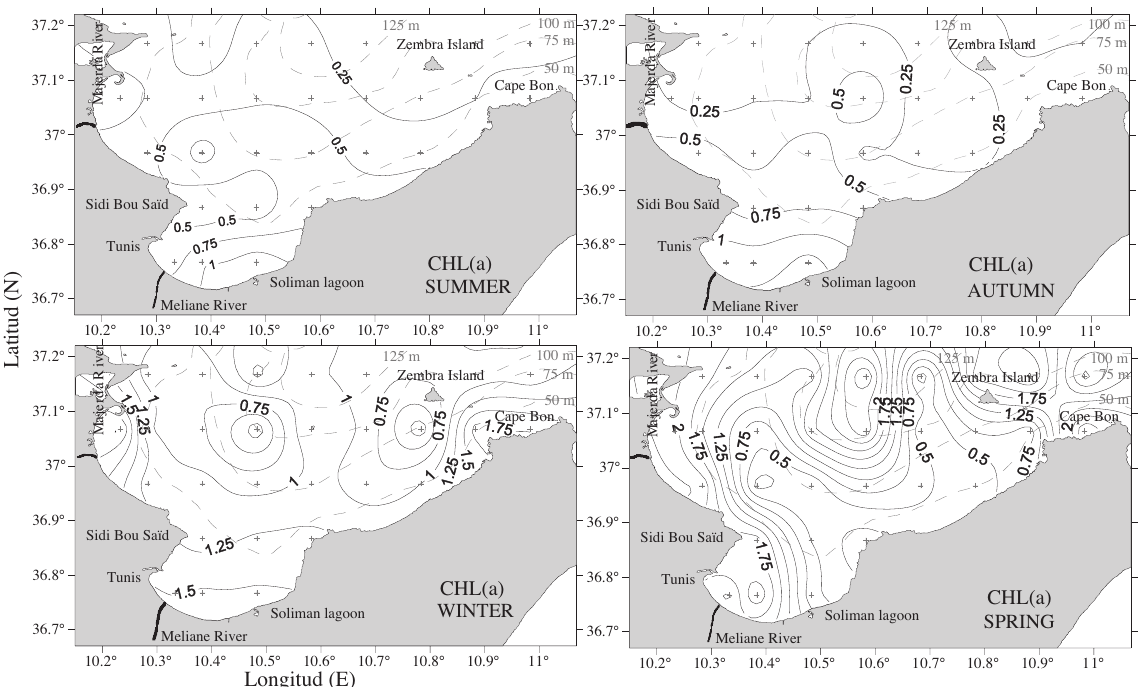
F IG . 4. – Seasonal spatial distribution of chloropyll- a (mg/m 3 )in the Gulf of Tunis.